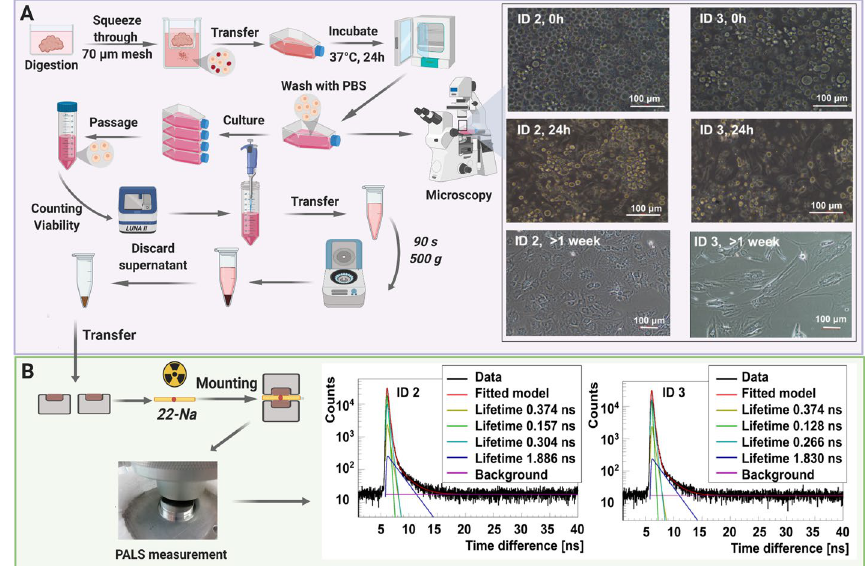
Fig. 2 Myxoma cell culture isolated from the tumor of patient ID 2 and ID 3. a (Left) The workflow of myxoma cell culture isolation. Cells have been isolated by tissue digestion and cultured to obtain the highest possible number of cells for the experiment. A micrograph presenting the primary culture of cells isolated from cardiac myxoma, upon seeding, and 24 h later with erythrocyte contamination. The latter has been washed out during the primary culture. Secondary culture after the first passage has been established after 1 week. A scale bar of 100 μm. b (Left) The workflow of PALS measurement. The centrifuged cells have been placed in both parts of the aluminum chamber with a radioactive source (red dot) encapsulated between them. The chamber has been mounted between detectors in the temperature-controlled aluminum holder. The measurements have been taken at 37 °C. (Right) Positronium lifetime spectra with fitted components for the myxoma cell culture isolated from the given patient. The dark yellow, green, turquoise, and blue lines denote direct annihilation in the source material, p-Ps annihilation component, direct annihilation in the sample, and o-Ps annihilation component, respectively. The spectra are shifted by the offset coming from the detection system configuration (~ 5 ns). The patient ID annotations are described in Table